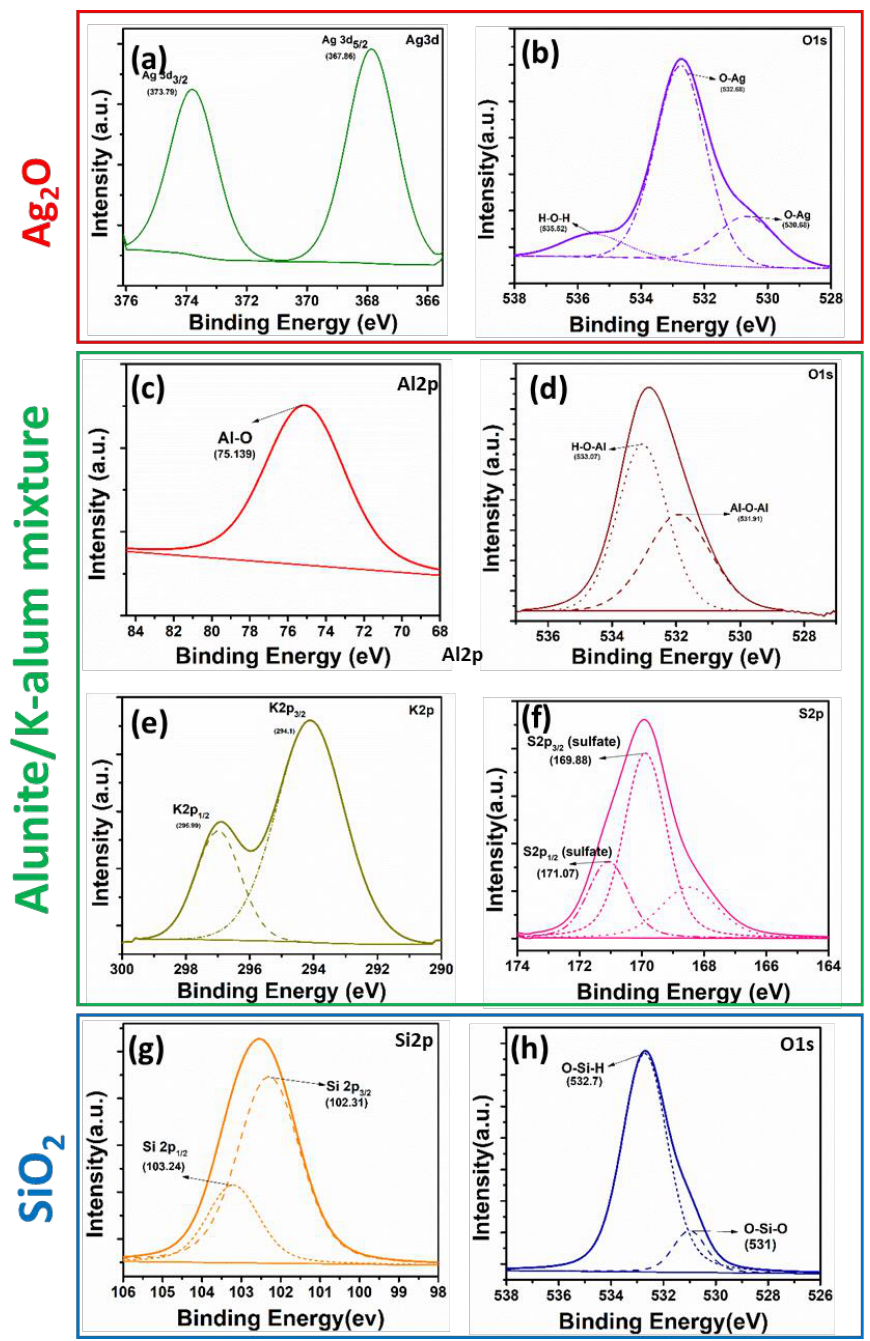
Figure 4. The XPS spectra of the recovered materials: ( a , b ) for Ag 2 O nanoparticles, ( c – f ) for alunite/K-alum mixture, and ( g , h ) for SiO 2.